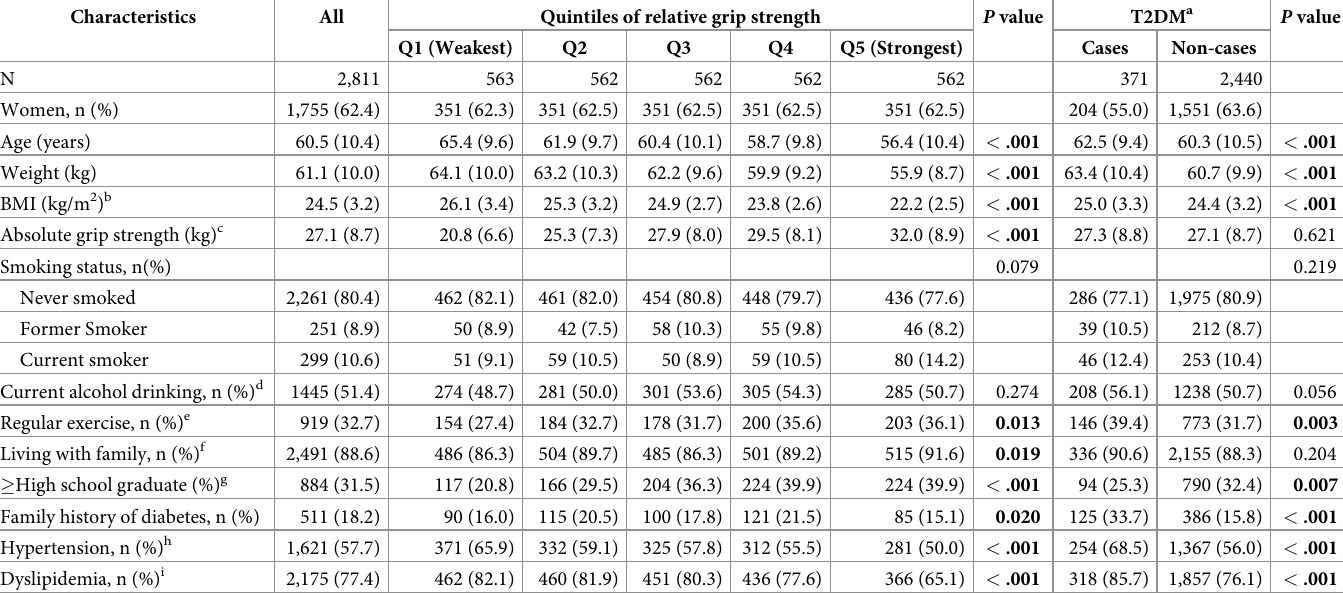
Table 1. Baseline characteristics of the participants by quintiles of relative grip strength.